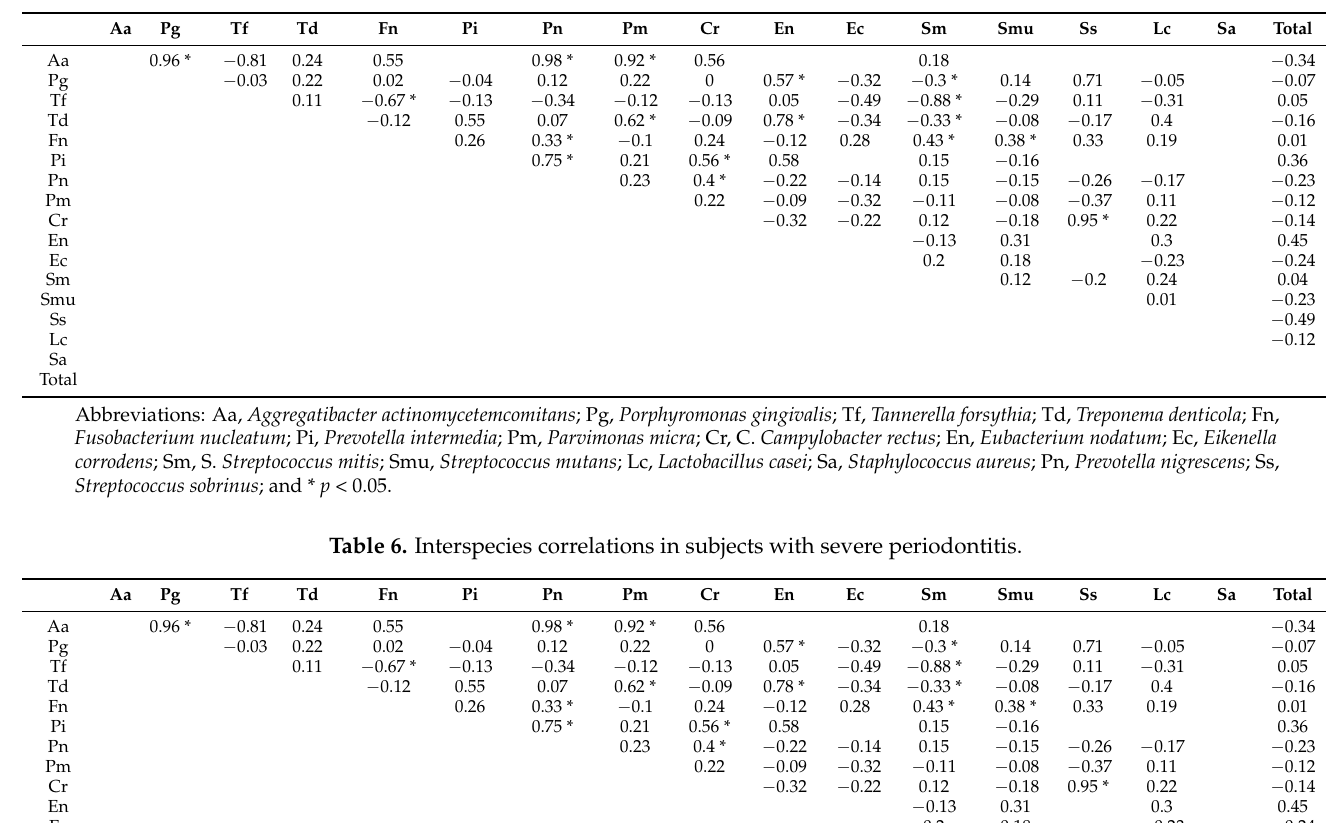
Table 5. Interspecies correlations in healthy subjects.